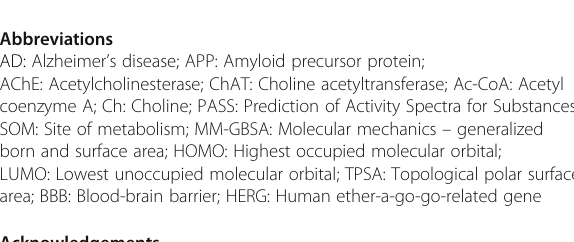
Additional file 1 : Supplementary Table S1 . List of different amino acids within the binding pocket of AChE that interact with the four best selected ligands, along with the bond distances and types of the